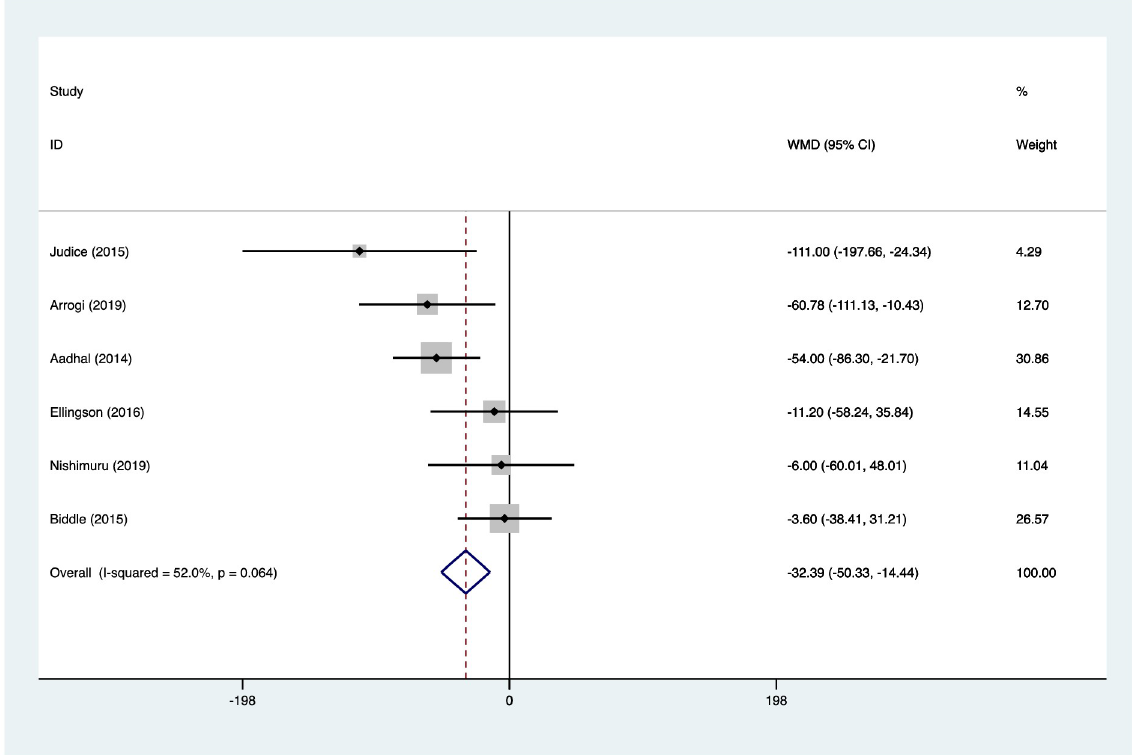
Fig 2. activPAL mean daily sitting time (minutes). H eterogeneity chi-squared = 10 . 43 (d . f . = 5) p = 0 . 064; I-squared (variation in Weighted Mean Difference (WMD) attributable to heterogeneity) = 52 . 0%; Test of WMD = 0 : z = 3 . 54 p = 0 . 000 .